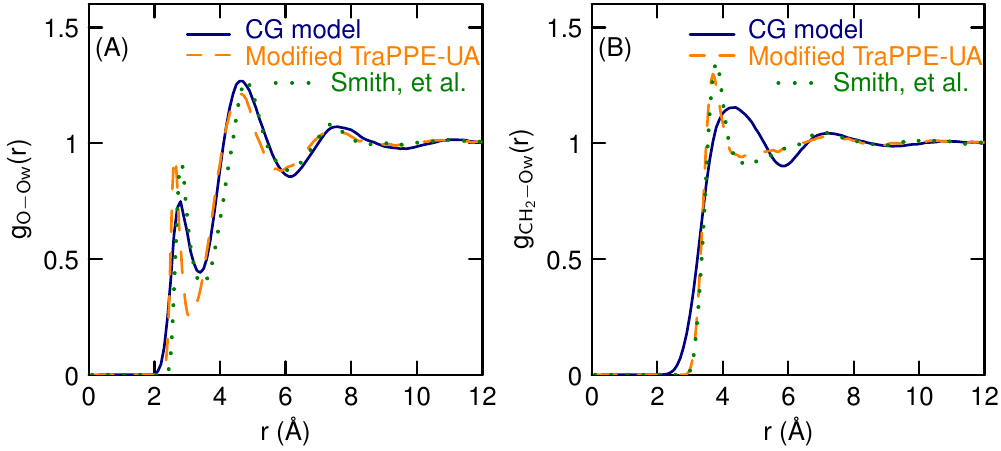
Figure 4. ( A ) Water oxygen-DME oxygen and ( B ) water oxgyen-DME carbon radial distribution functions.